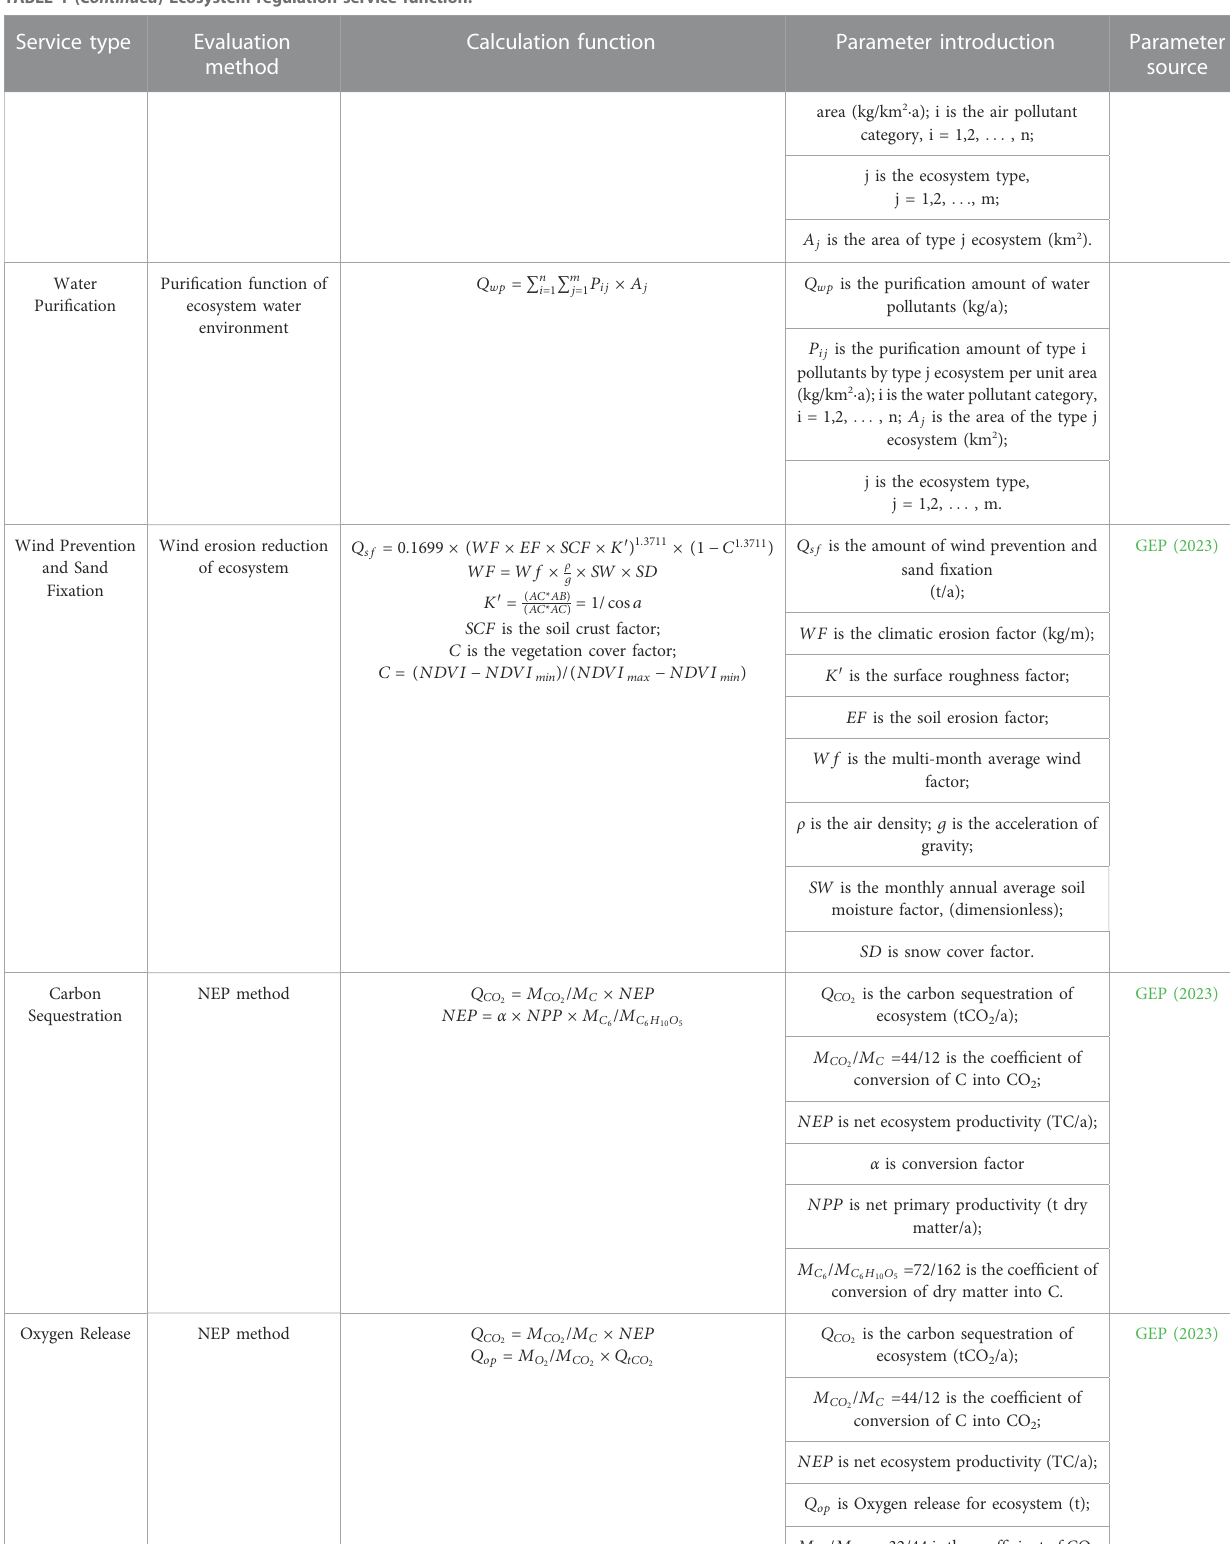
TABLE 1 ( Continued ) Ecosystem regulation service